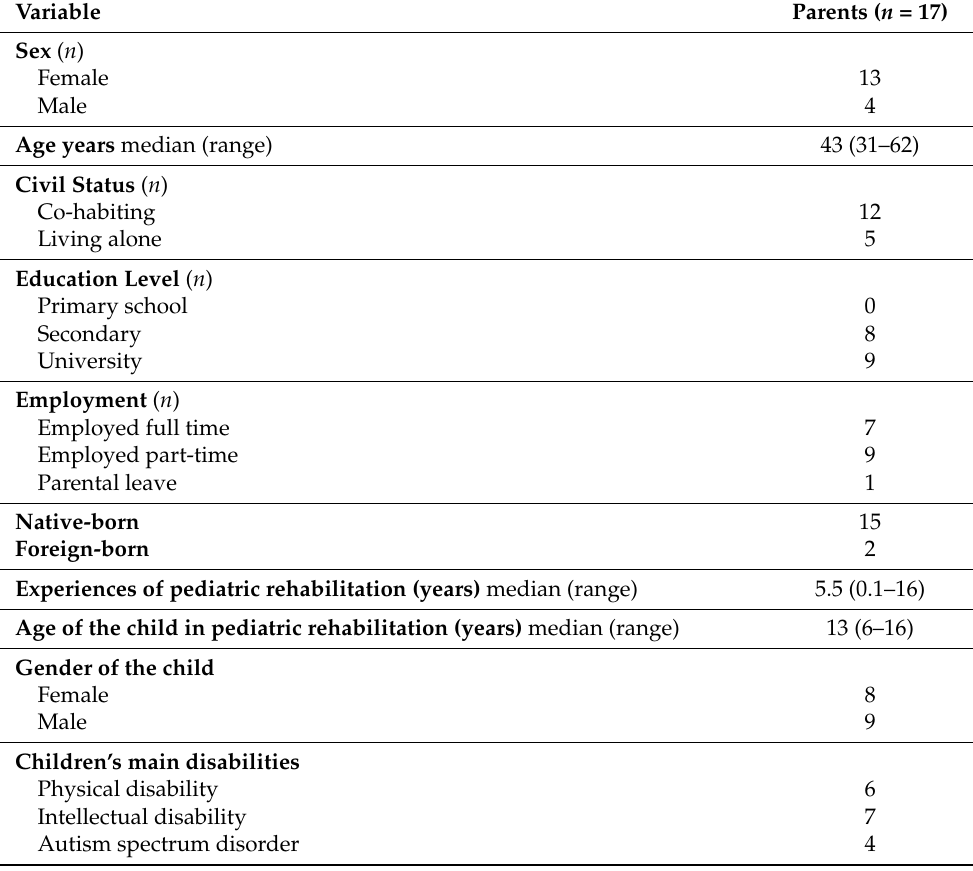
Table 1. Sociodemographic data of the participating parents to children attending pediatric rehabili- tation services ( n =